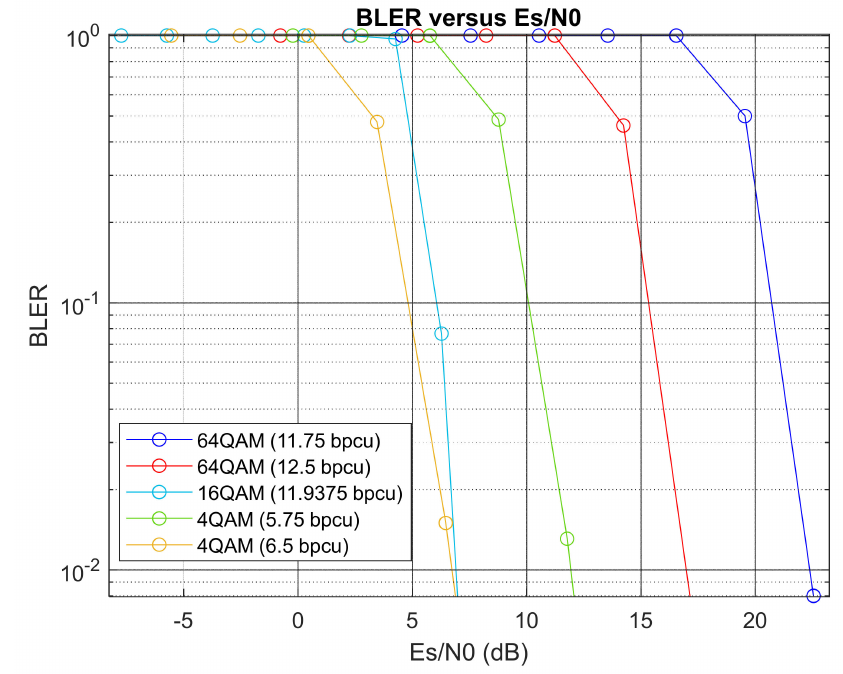
Figure 5. BLER vs. ( E s / N 0 ) dB curves for PT-GSFIM in an MU scenario with N rx = 5, 64QAM (11.75 bpcu and 12.5 bpcu), 16QAM (11.9375 bpcu) and 4QAM (5.75 and 6.5